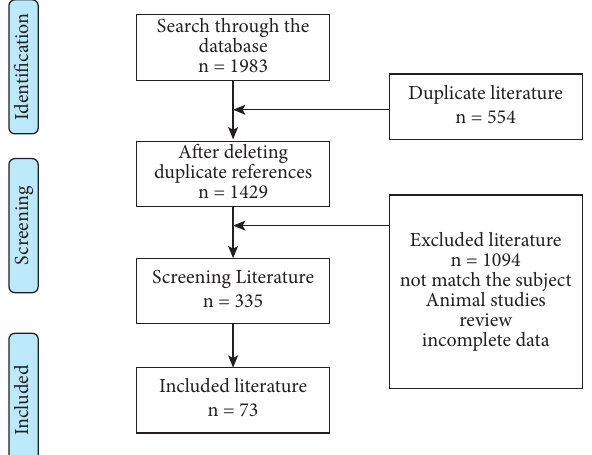
Figure 1: Literature screening process and